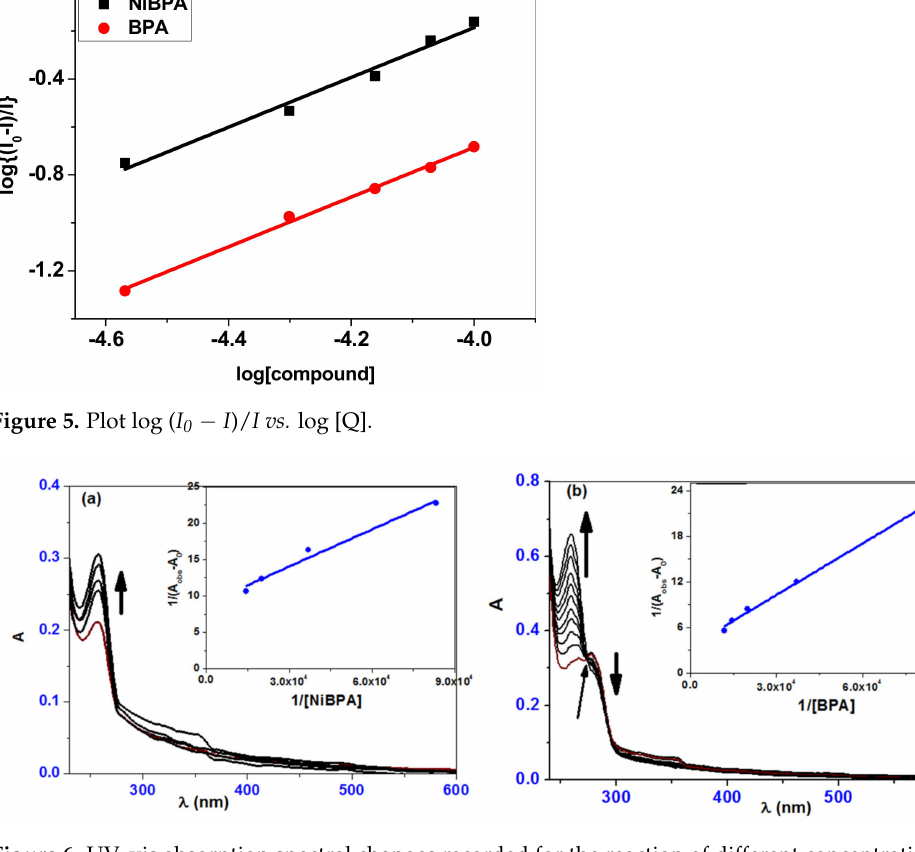
Figure 6. UV–vis absorption spectral changes recorded for the reaction of different concentrations of ( a ) NiBPA and ( b ) BPA with